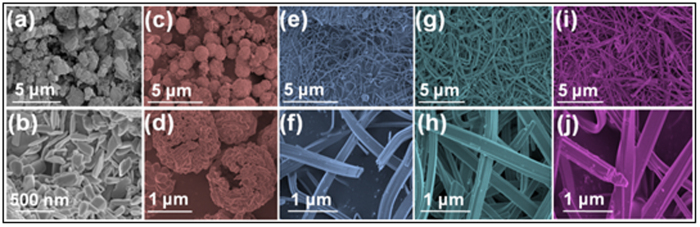
SEM images of the Sb4O5Cl2 samples prepared at pH values of (a,b) 1, (c,d) 2, (e,f) 3, (g,h) 4 and (i,j) 5 through hydrothermal process (T = 160 °C, t = 12 h).